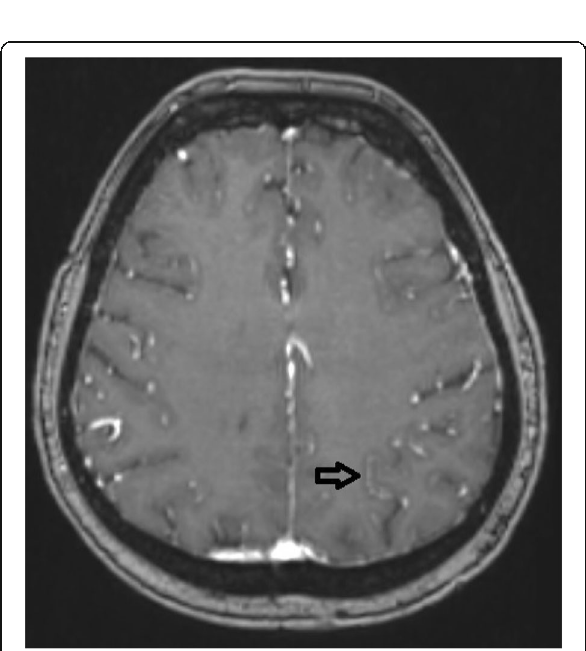
Fig. 2 (abstract P0123). Hyperperfusion of leptomeningeal